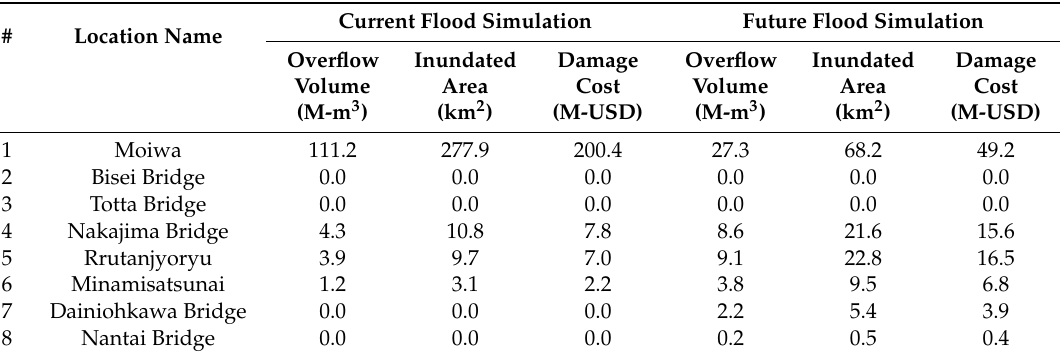
Table 5. Agricultural damage losses by